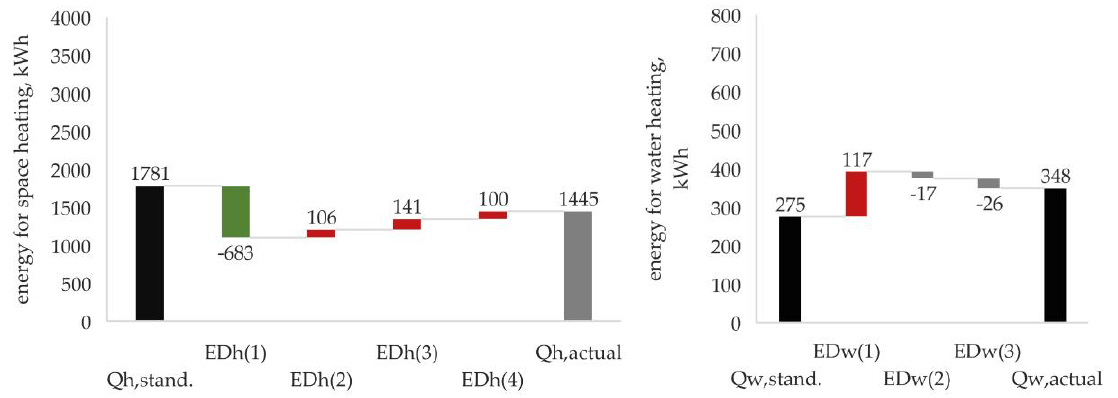
Figure 10. Influence of individual parameters on the values of energy consumption for heating ( Q h ) and hot water preparation ( Q w ) for unit F. and hot water preparation ( Q w ) for unit